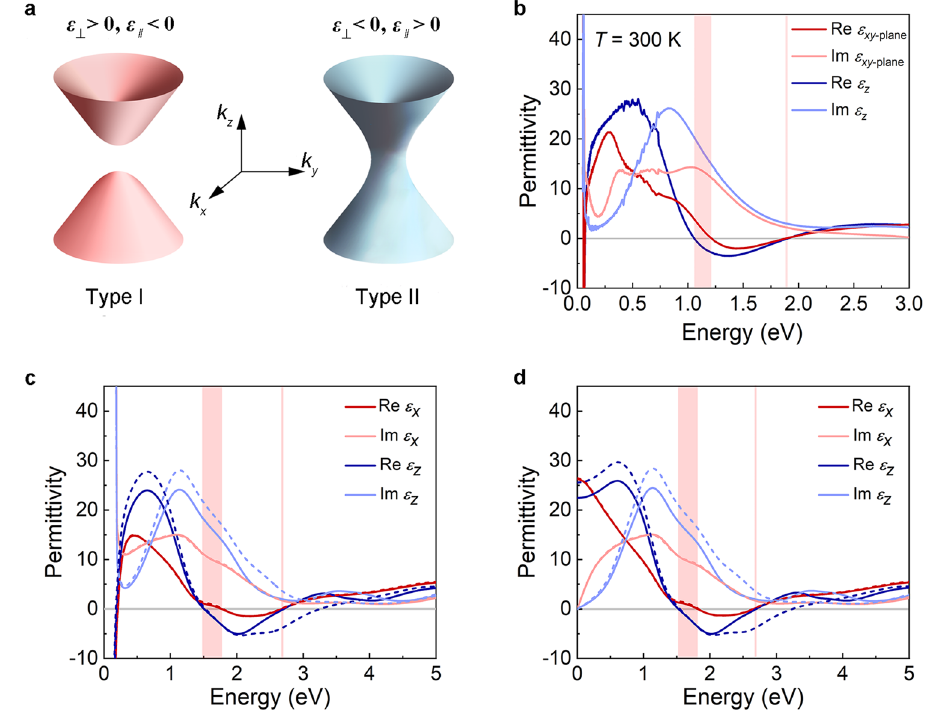
Fig. 2 | Dielectric properties of α -Ti 2 O 3 crystal. a Schematic diagrams of type-I and type-II hyperbolic materials. b Real and imaginary parts of the permittivity along the xy- plane and the z- direction, collected by ellipsometry at room tem- perature. c Real and imaginary parts of the permittivity of α -Ti 2 O 3 obtained from fi rst-principles calculations. d Real and imaginary parts of the permittivity